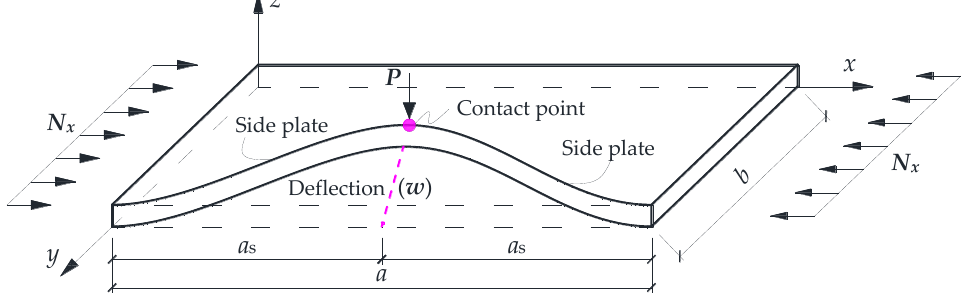
Figure 1. Theoretical analysis model for the flange of H-section steel core.